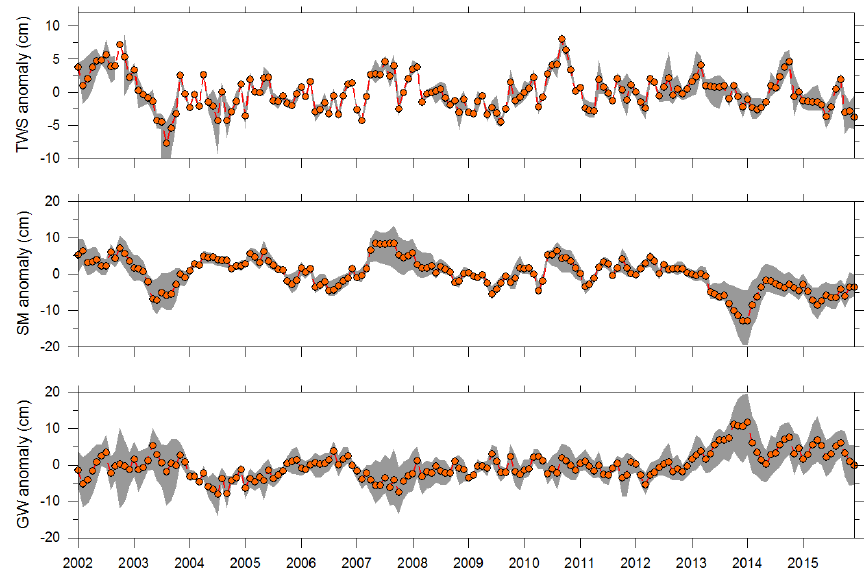
Figure 11. Same as Fig. 10 but for the study region in the Netherlands.